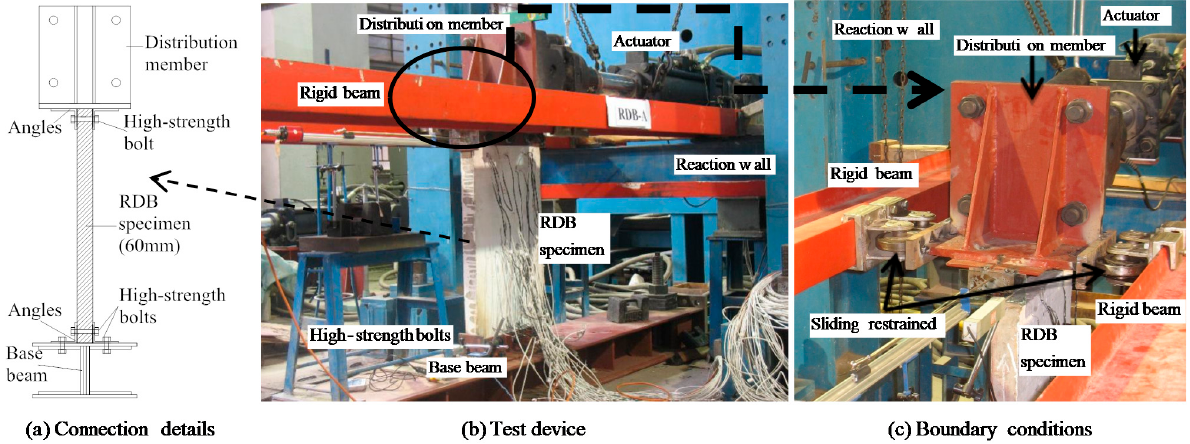
Figure 2. Details of the test device, specimens, connection details and boundary conditions. Three displacement-based linear transducers were used for measuring the lateral displacement of the specimen. They were placed at the two sides of the RDBs and the base beam, and they were used to measure the relative lateral deformation of the test specimens. The stress distribution of the RDBs was traced by uniaxial strain gauges, and